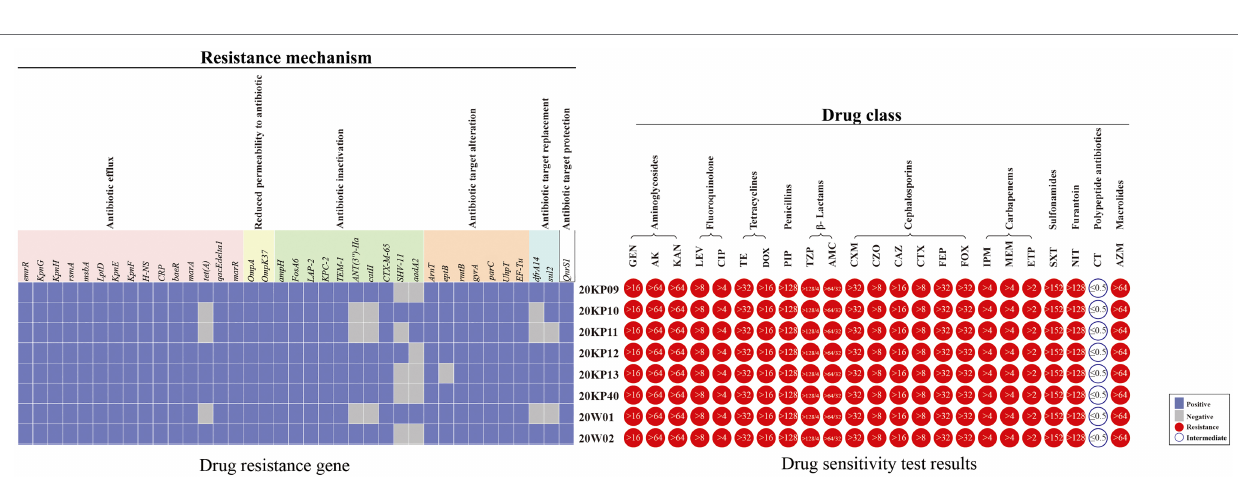
FIGURE 3 | The drug resistance gene distributions and antibiotic resistance spectrum of eight XDRKp strain. The 23 drugs in the drug sensitivity test included Gentamicin (GEN), Amikacin (AK), Kanamycin (KAN), Levofloxacin (LEV), Ciprofloxacin (CIP), Tetracycline (TE), Doxycycline (DOX), Piperacillin (PIP), Piperacillin/ Tazobactam (TZP), and Amoxicillin/Clavulanicacid (AMC). Cefuroxime (CXM), Cefazolin (CZO), Ceftazidime (CAZ), Cefotaxime (CTX), Cefepime (FEP), Cefoxitin (FOX), Imipenem (IMP), Meropenem (MEM), Ertapenem (ETP), Trimethoprim/sulfamethoxazole (SXT), Nitrofurantoin (NIT), Colistin (CT), and Azithromycin (AZM). The value in the circle of the drug sensitivity test results is the MIC value of the